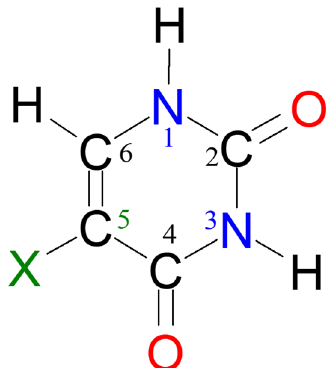
Figure 1. Schematic structure of uracil (U, X = H) and its four 5-halogenouracil (5XU) derivatives (X = F, Cl, Br and I) with atom numbering.